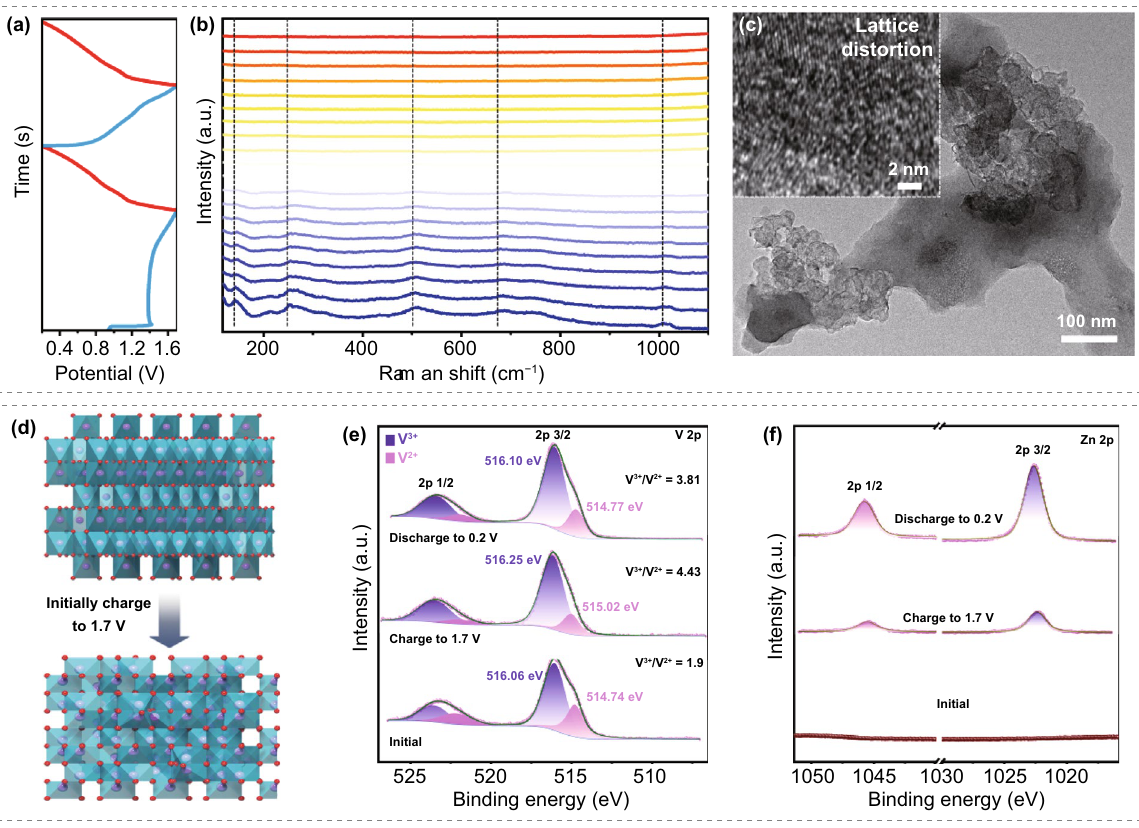
Fig. 4 a and b In-situ Raman spectrum of the initial two cycles for V 2 O 3 /C electrode using the 50% PEG electrolyte. c TEM image and HRTEM image (inset) of the V 2 O 3 /C after charged to 1.7 V in the first cycle. d Schematic illustration of lattice distortion of V 2 O 3 after initially charged to 1.7 V. High-resolution XPS spectra of e V 2 p and f Zn 2 p of the V 2 O 3 /C electrode at different state of the first